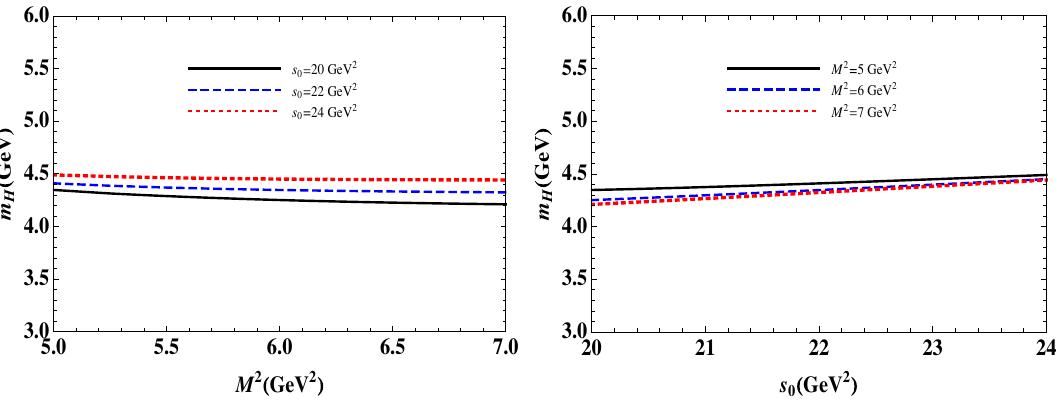
Fig. 1 The mass of the charm-nonstrange hybrid meson with the quantum numbers J P ( C ) = 1 − ( − ) as a function of the Borel parameter M 2 at fixed values of s 0 (left panel), and as a function of the continuum threshold s 0 at fixed values of M 2 (right